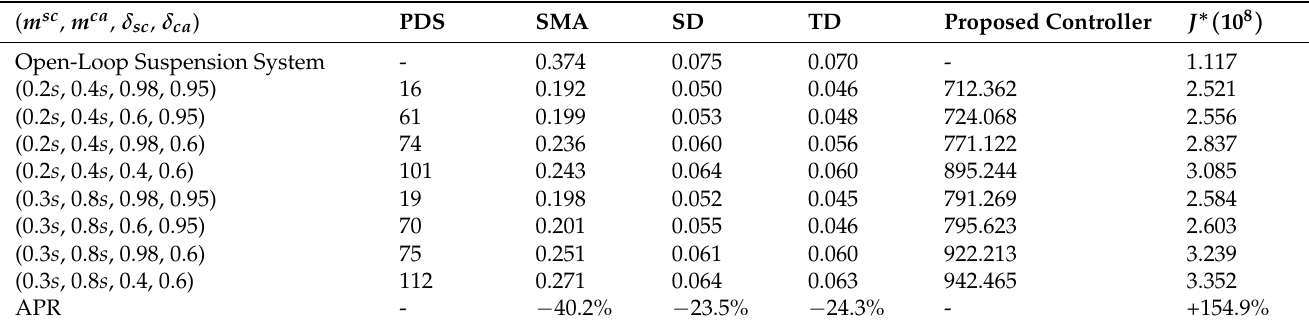
Table 4. RMS values of performance indicators under road roughness with G d ( Ω 0 ) = 1024 × 10 − 6 m 3